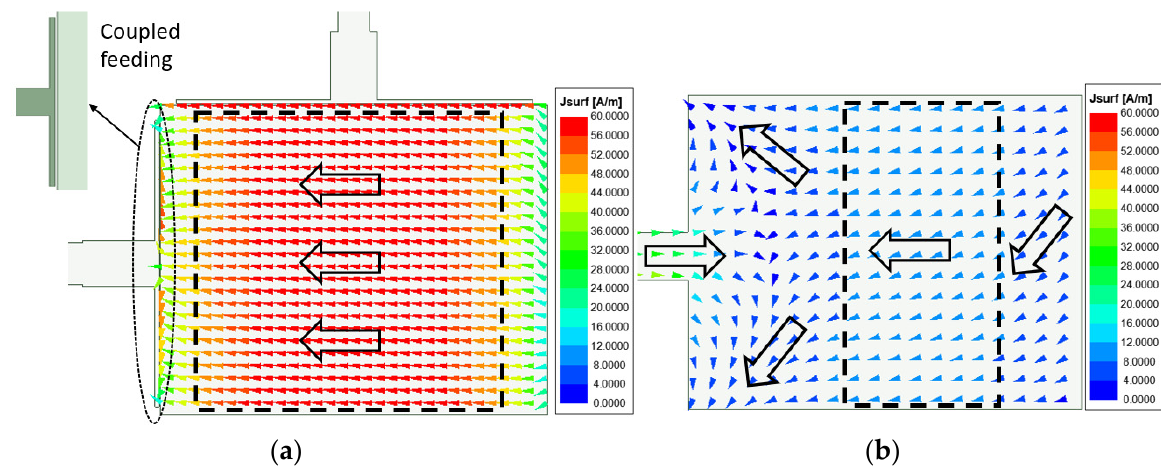
Figure 6. Current distribution of two different feeding methods. ( a ) Coupled feeding. ( b ) Direct feeding.